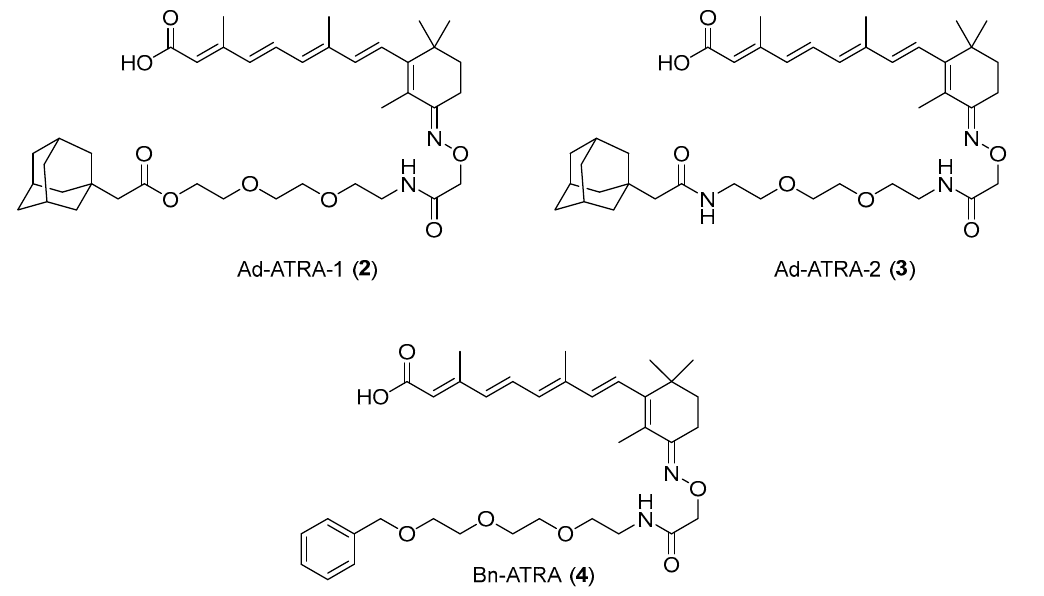
Figure 2. Chemical structures of designed compounds.